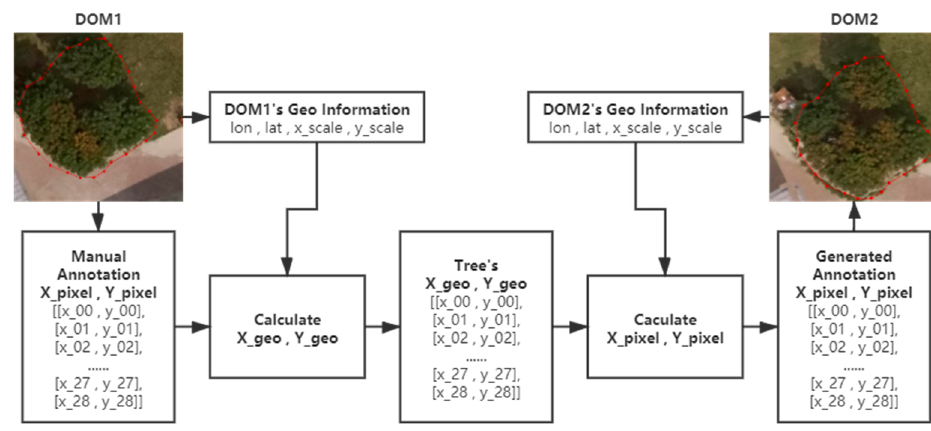
Figure 4. The principle of the annotation method.